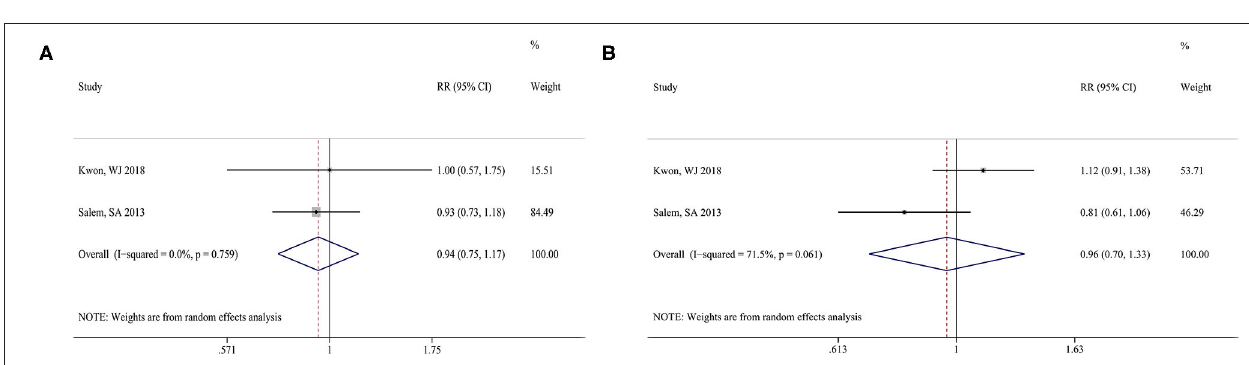
FIGURE 4 | Forest plot of the overall risk ratios of clinical efficacies of rosacea treated compared with PDL than Nd:YAG. PCA (A) and PGA (B) . PDL, pulsed dye laser; Nd:YAG,